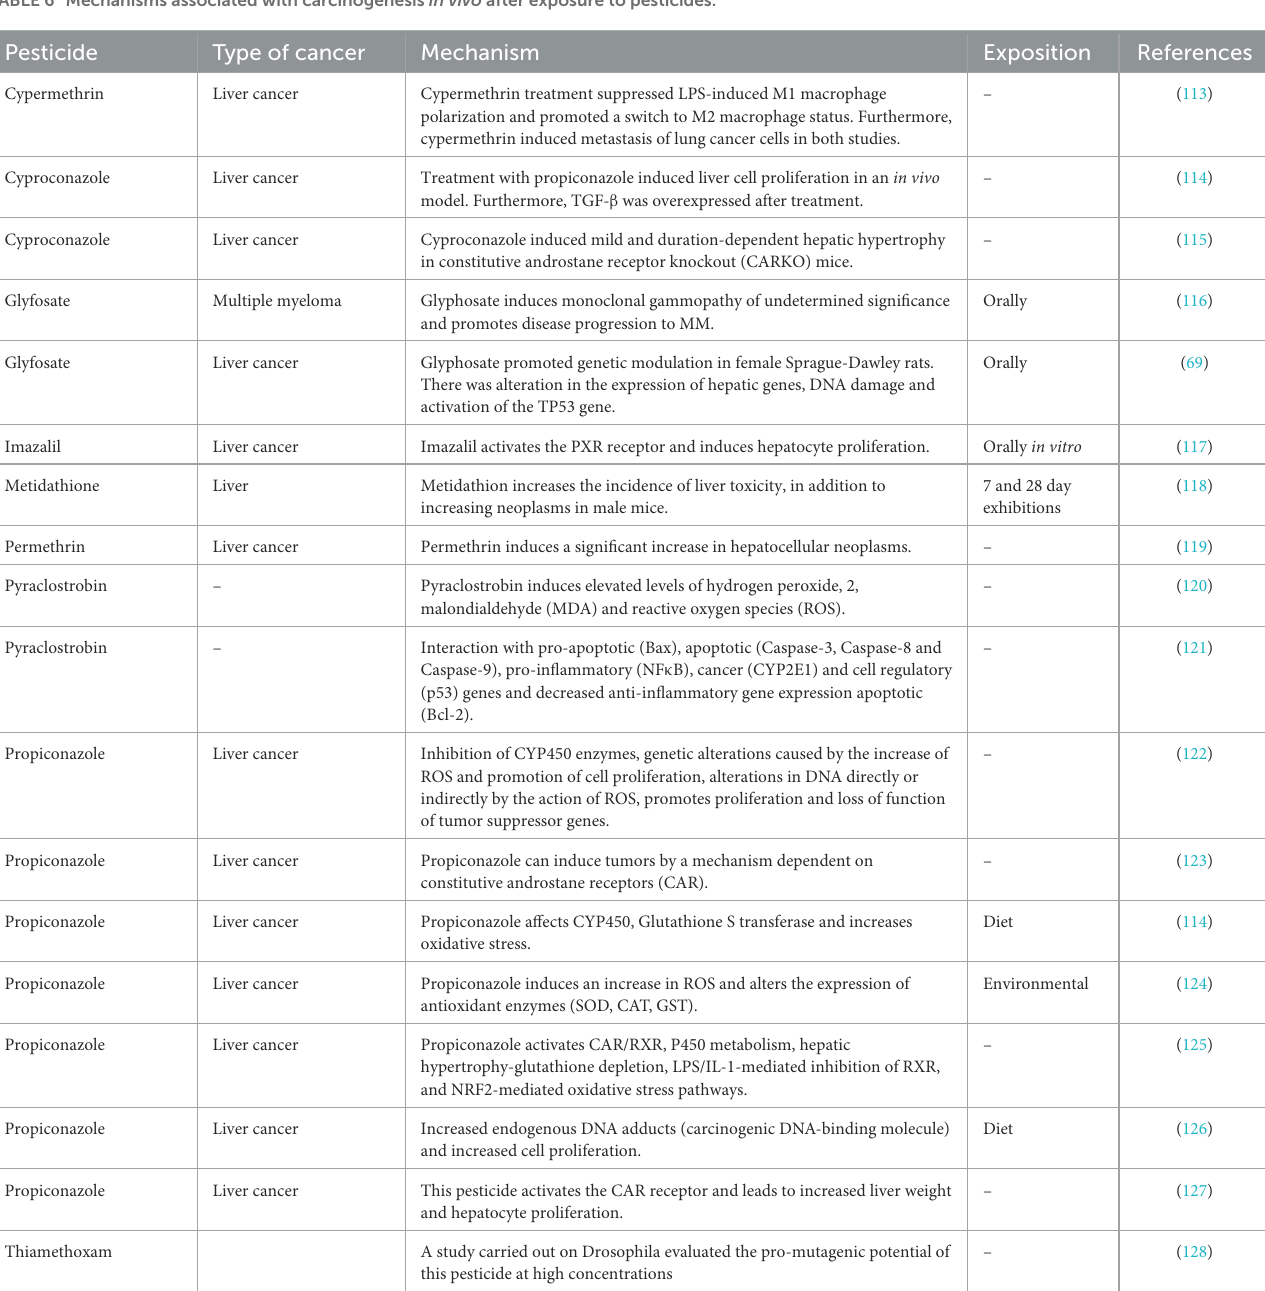
TABLE 6 Mechanisms associated with carcinogenesis in vivo after exposure to